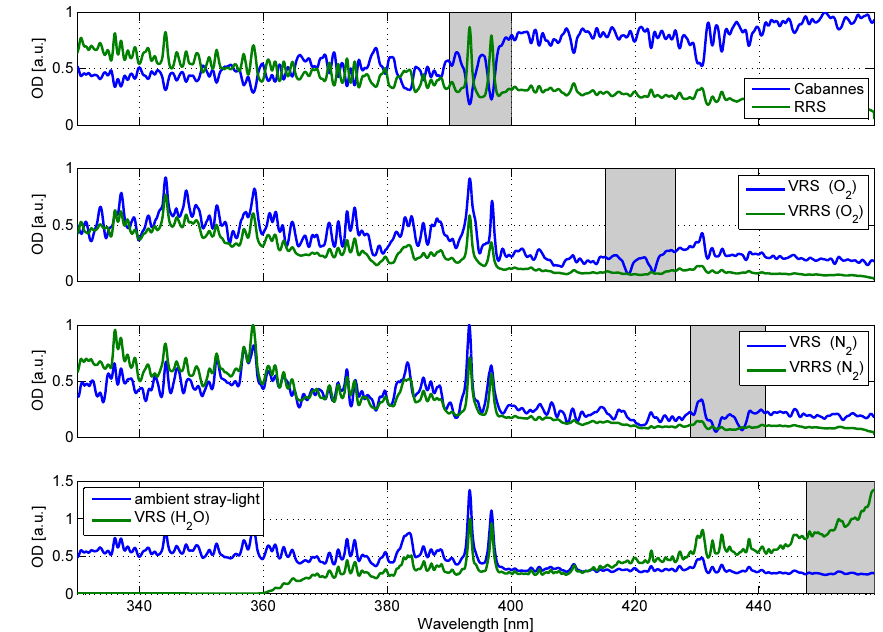
Figure 3. The apparent optical depths according to Eq. (18) related to the additional intensities in Fig. 2.